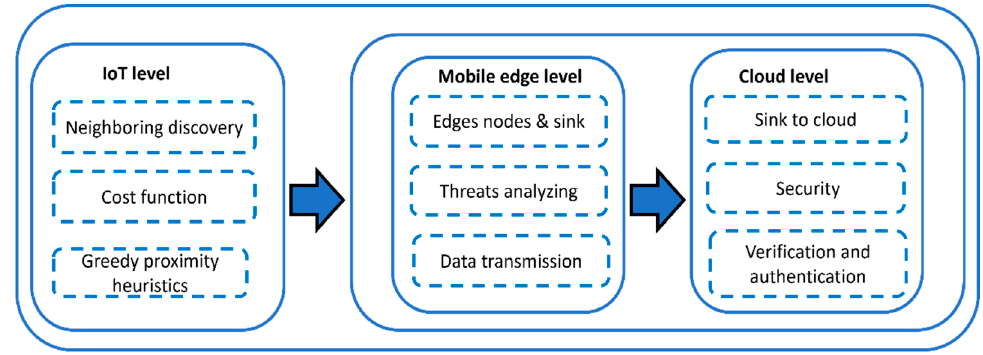
Figure 1. Components of the proposed medical model using IoT.